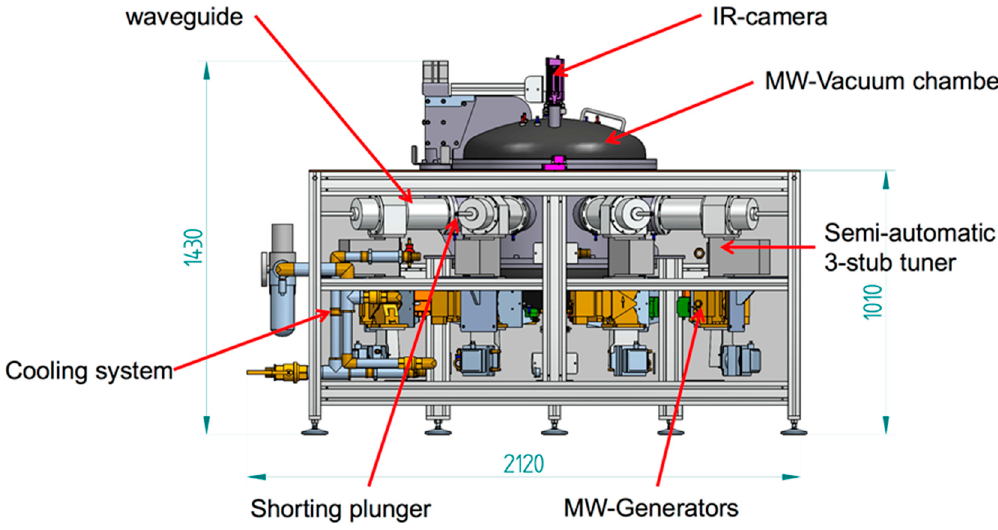
Figure 3. Microwave pyrolysis plant (unit: mm).